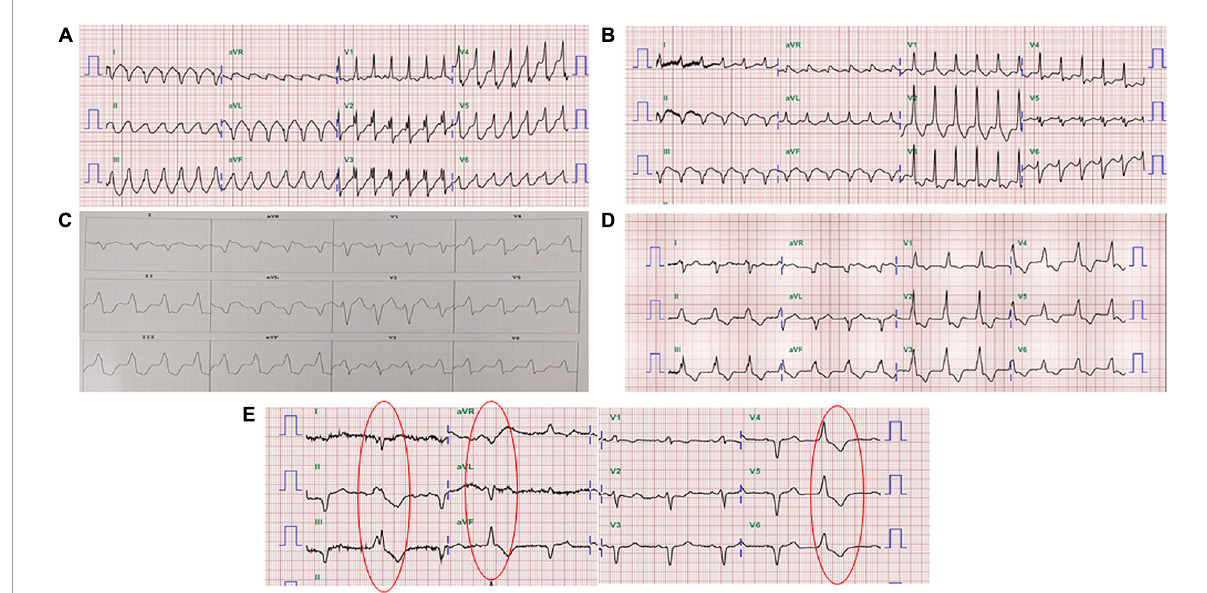
FIGURE1 Twelve-lead electrocardiography of the patient. (A) VT with right bundle branch block morphology and an inferior axis. (B) VT with right bundle branch block morphology and a superior axis. (C) VT with the origin in the RVOT. (D) Slow VT with all positive concordance in the precordial leads and an inferior axis suggested at a different location from the initial therapy zone. (E) The morphology of ventricular premature beats was the same as the morphology of the slow